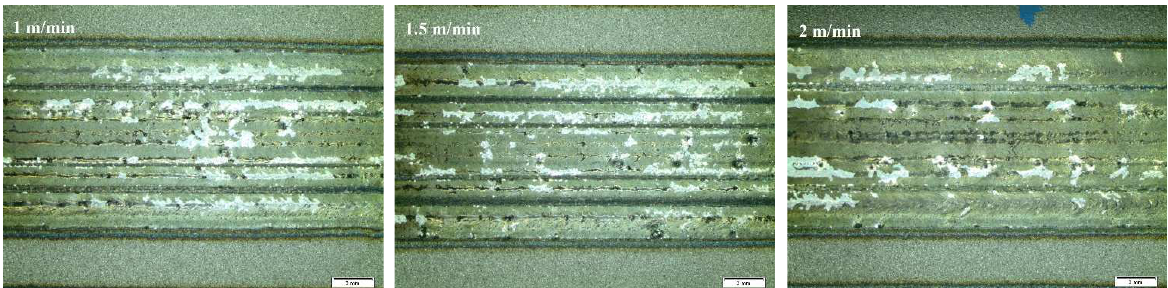
Figure 5. Morphology of the laser-alloyed tracks of surface of SSSs for sample 2.